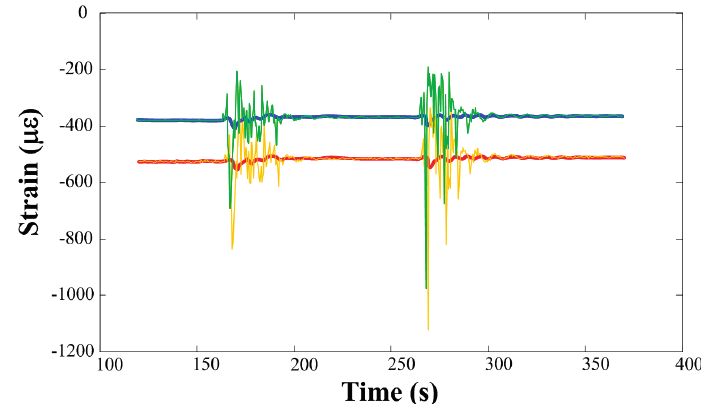
Figure 12. Strain fluctuation due to artificial wind vibration and results of the moving-average filter (green and blue curves: strain and its processed result without temperature compensation; orange and red curves: strain and its processed result with temperature compensation).